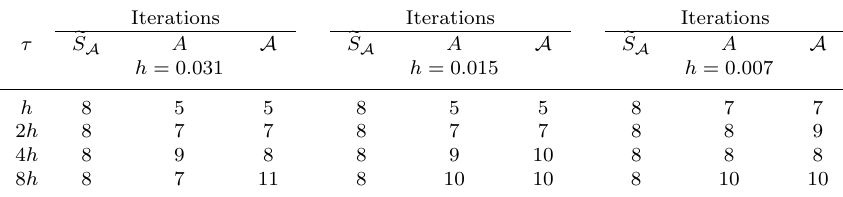
Table 2. Number of